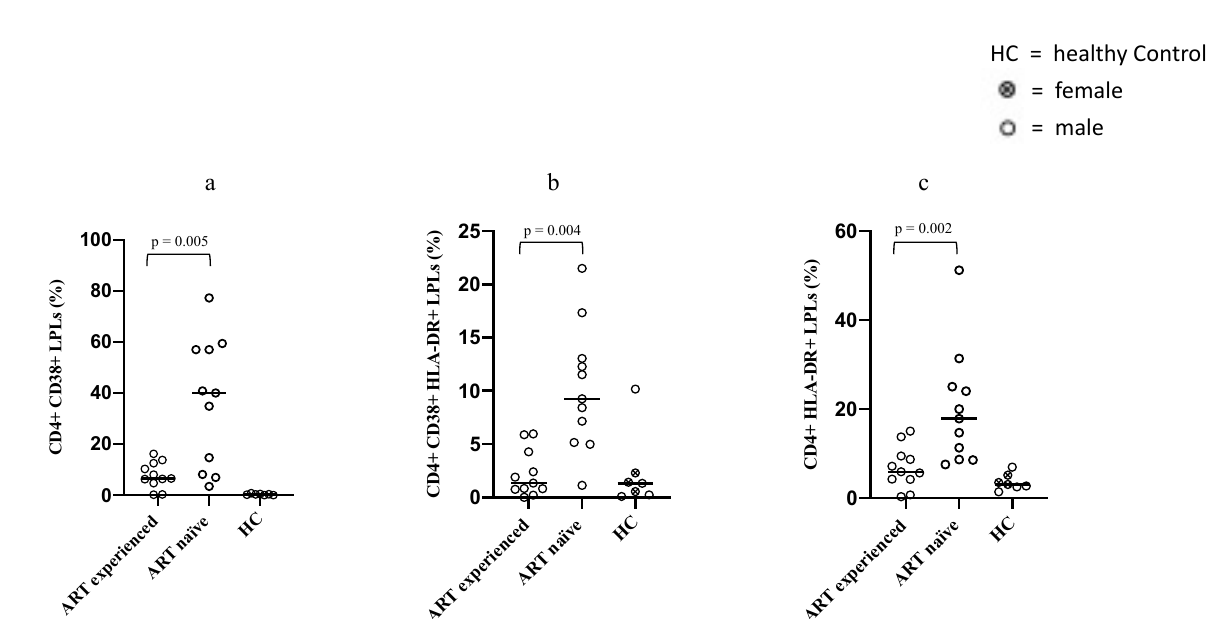
Figure 2. This figure shows comparison for CD38 + CD4 + LPLs ( a ), HLA-DR + CD4 + LPLs ( b ) and double positive CD38 + HLA-DR + CD4 + LPLs ( c ) detected within mucosal biopsies between ART-naïve PLWH and long-term ART-treated PLWH. Each dot represents a patient biopsy, while the horizontal line represents the median. The healthy control group’s results are shown on the right of each panel. p -values were determined by Mann–Whitney U test.